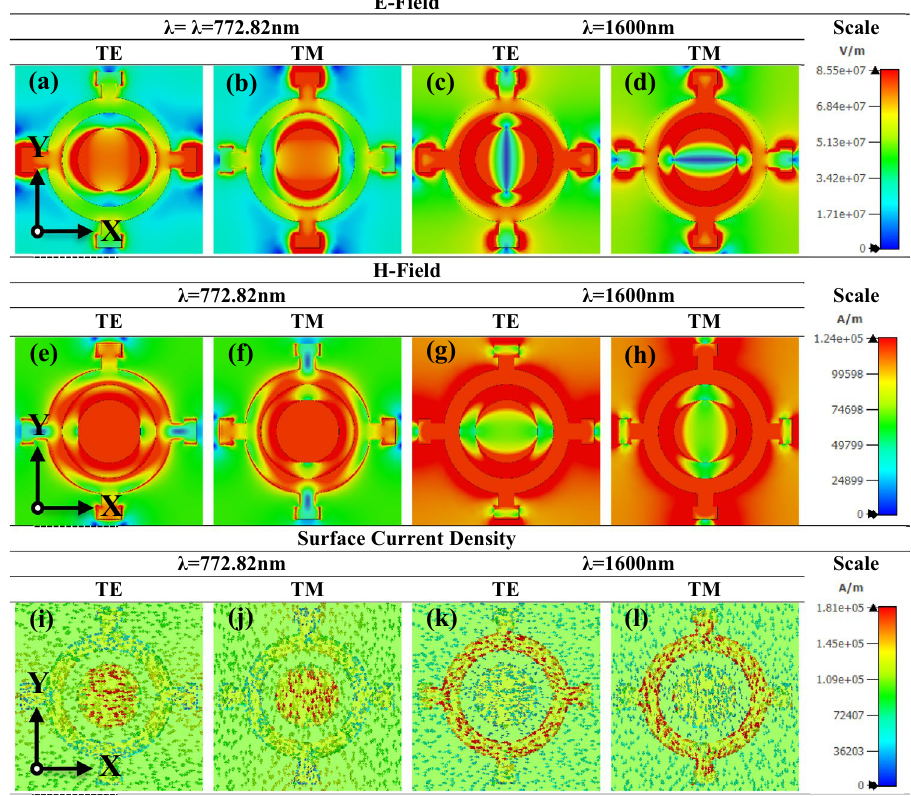
Figure 11. Demonstration of ( a – d ) E-field of the proposed model for TE and TM mode in 772.82 nm (max point) and 1600 nm (min point) with scale bar (V/nm) in y-x axis cross sectional view, ( e – h ) H-field of the proposed model for TE and TM mode in 772.82 nm (max point) and 1600 nm (min point) with scale bar in A/m in y–x axis cross sectional view, and ( i – l ) surface current density of the proposed absorber for TE and TM mode in 772.82 nm (max point) and 1600 nm (min point) with scale bar (A/m) in y–x axis cross sectional